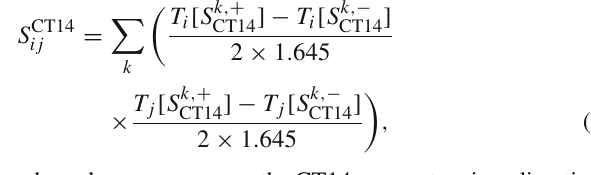
that eigendirection (all calculated with the central EPPS16 nuclear modifications). The factors 1.645 in the denomina- tors are used to scale the nominally 90%